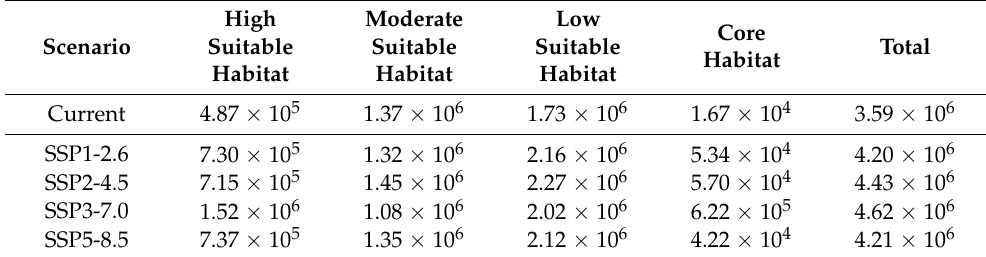
Figure 2. Current distribution area with different potential habitats of N. chinensis according to occurrence records. Except for blue areas, all colors represent potential habitat distribution. Potential habitats were classified into high potential habitats (>0.6), moderate potential habitats (0.4~0.6), and low potential habitats (0.2~0.4) according to suitability value. Table 2. Change of suitable habitat area and core distribution (km 2 ) of N. chinensis in current and future under four levels of greenhouse gas emission